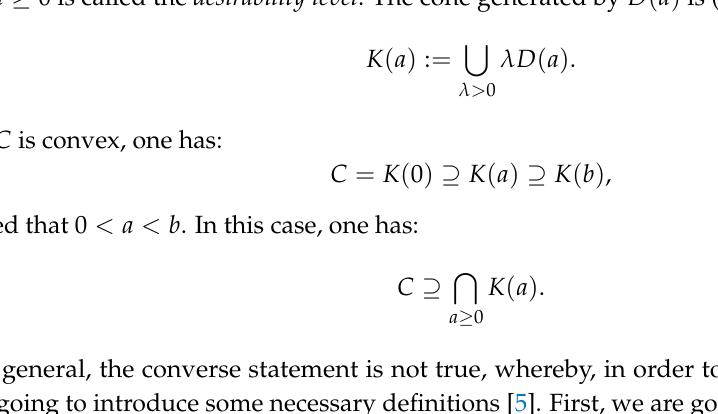
Figure 7. In yellow, elements in M with a unique (positive) price. In orange, elements in K unique (positive) price. In white, elements in F with a unique (negative or null) price. Source: Own